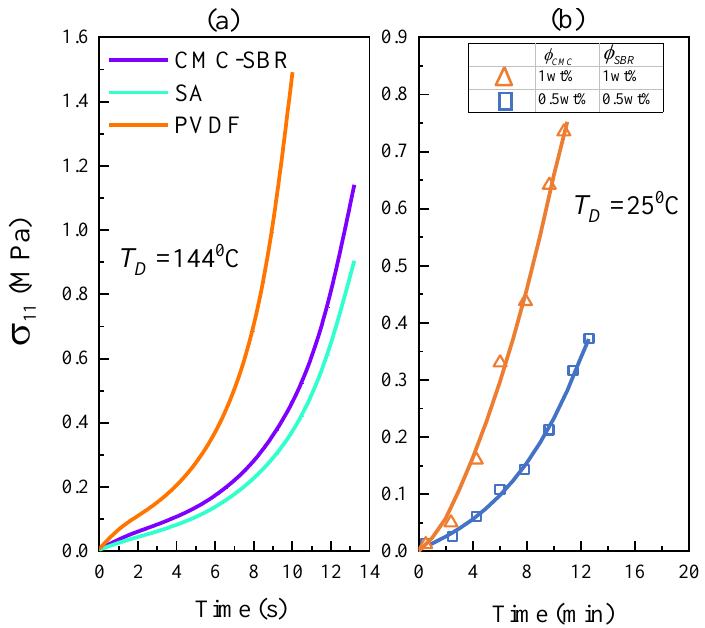
Figure 5. Internal stress against drying time for ( a ) NMC electrode slurries ( b ) Graphite/CMC- SBR/CB slurries (curves: predicted, dots: experimental).